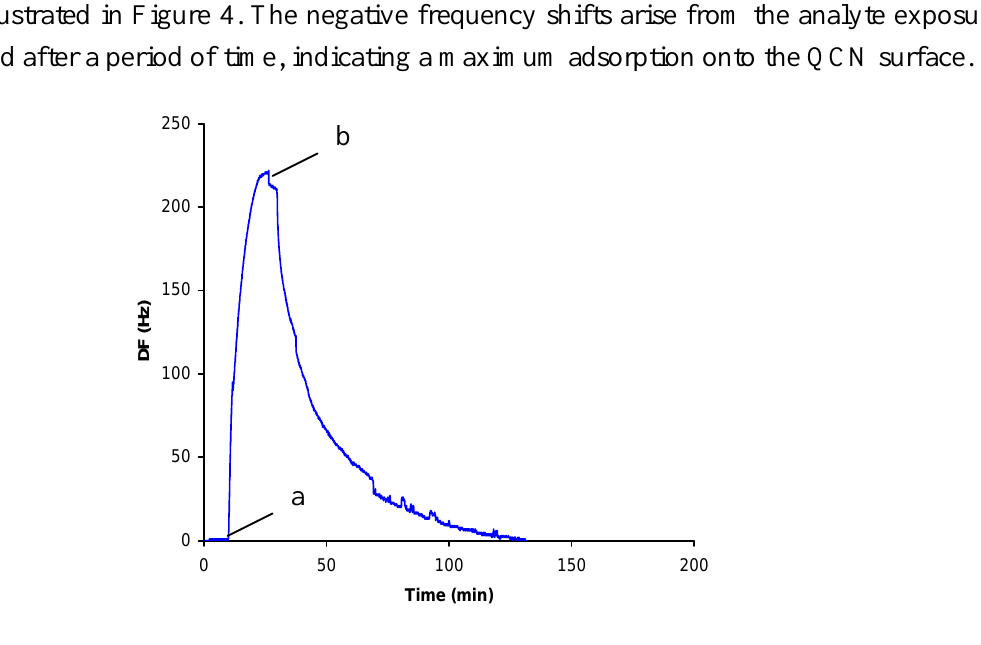
Figure 4. Typical frequency changes of the polystyrene-modified quartz crystal electrode exposed to 15 mg l − 1 toluene in air: (a) sample injection; (b) sample desorption by purging air through the cell. Polymer cast from a 0.5% (w/v) of polystyrene/chloroform solution.